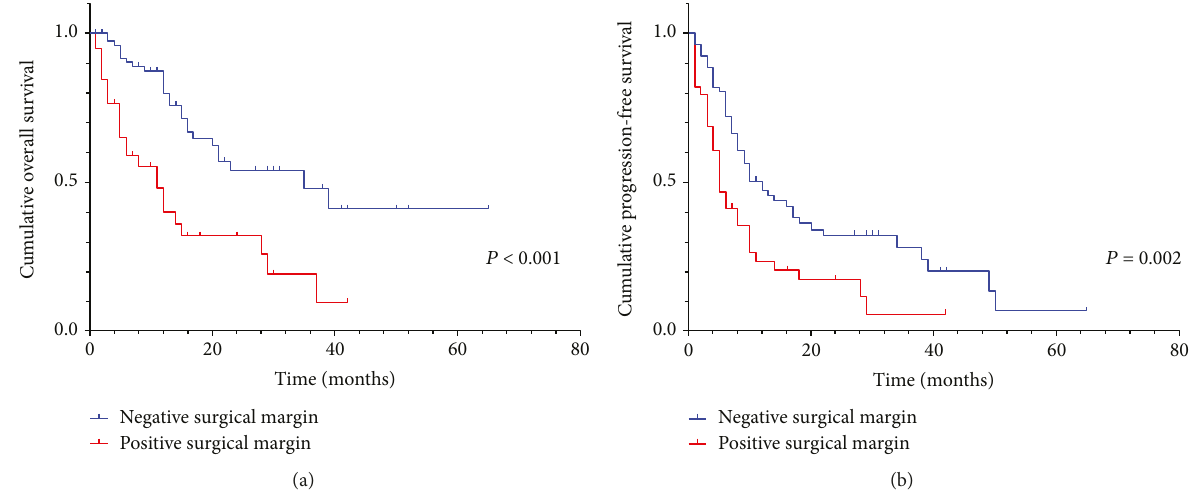
Figure 2: (a, b) Kaplan – Meier curve for OS and PFS of 119 CCA patients strati fi ed by surgical